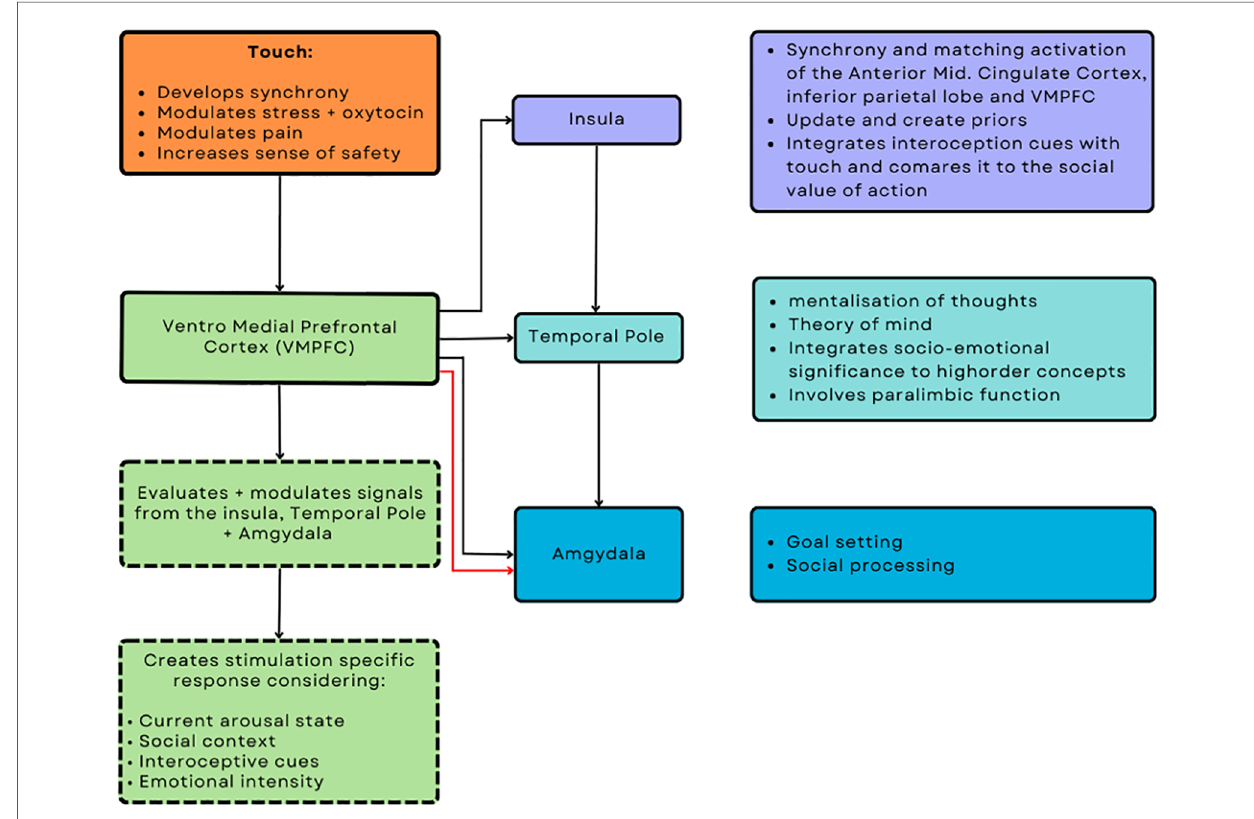
FIGURE 1 Putative neuromodulatory effects of touch from an interoceptive and interpersonal inference